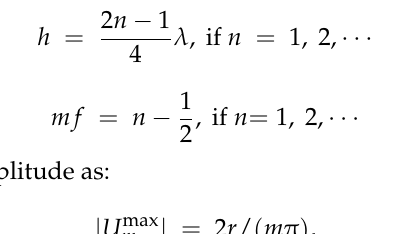
The distance ∆ x i between the i th and ( i +1) th ridges should be: